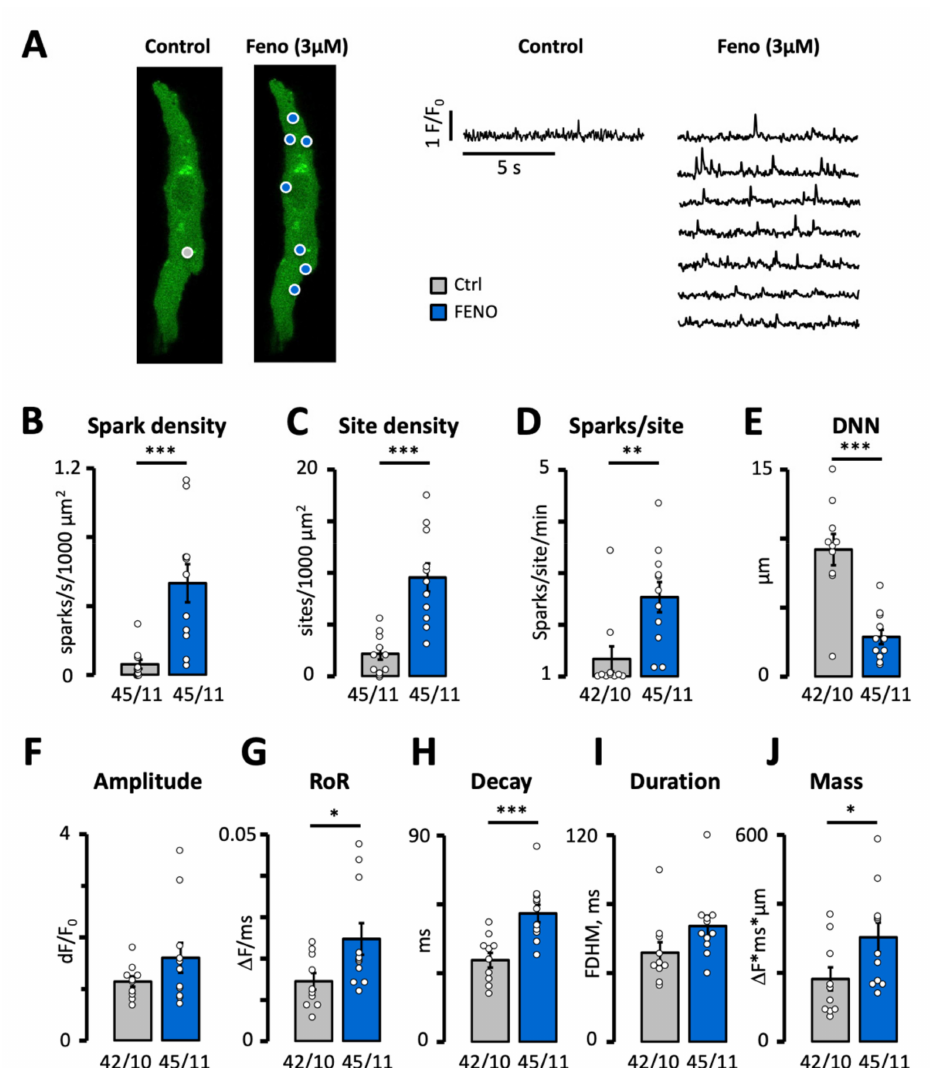
Figure 1. Effect of fenoterol on calcium spark frequency and properties. ( A ) Calcium spark recordings in a patient before and after exposure to 3 µ M Feno. Spark sites are marked with circles and the signal for each site is shown on the right. Impact of Feno on ( B ) spark density, ( C ) spark site density, ( D ) spark frequency per site. p -values in ( B – D ) were obtained using Wilcoxon rank sum exact test. ( E ) Distance to nearest neighbor (DNN). ( F ) Spark amplitude. ( G ) Rate of rise (RoR). ( H ) Decay time constant. ( I ) Full duration at half maximum (FDHM). ( J ) Spark mass. p -values in ( E – J ) were obtained using Student’s t -test. Statistically significant differences between pairs of bars are indicated with *: p < 0.05, **: p < 0.01; ***: p < 0.001. Circles in ( B – J ) correspond with the values of individual data points. Number of cells/number of patients is given below